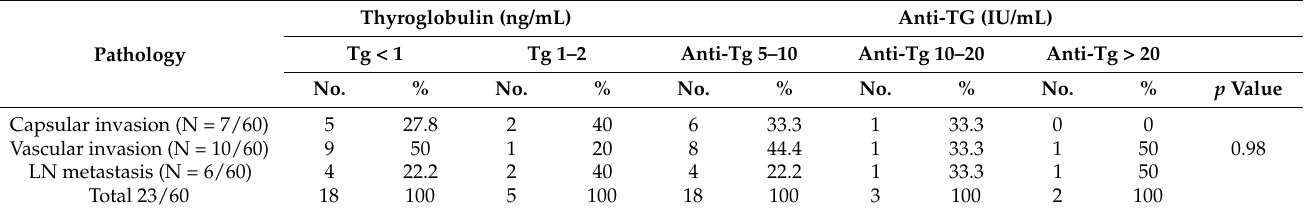
Table 6. Distribution of the patients according to the recorded pathology regarding Tg and anti-Tg.